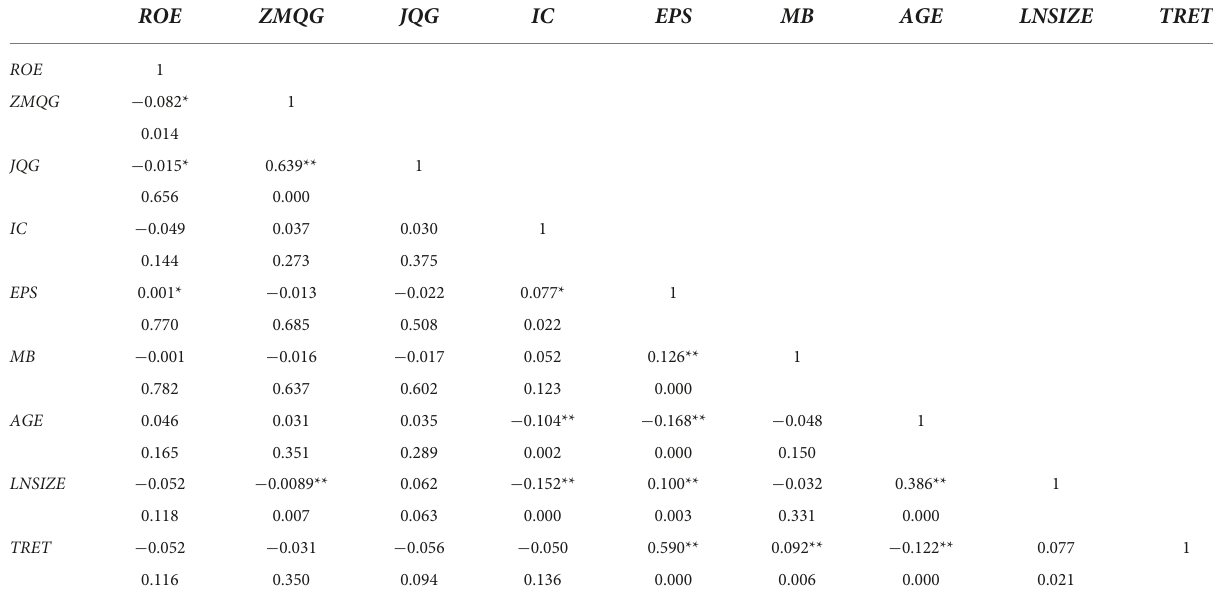
TABLE 5 Correlation analysis